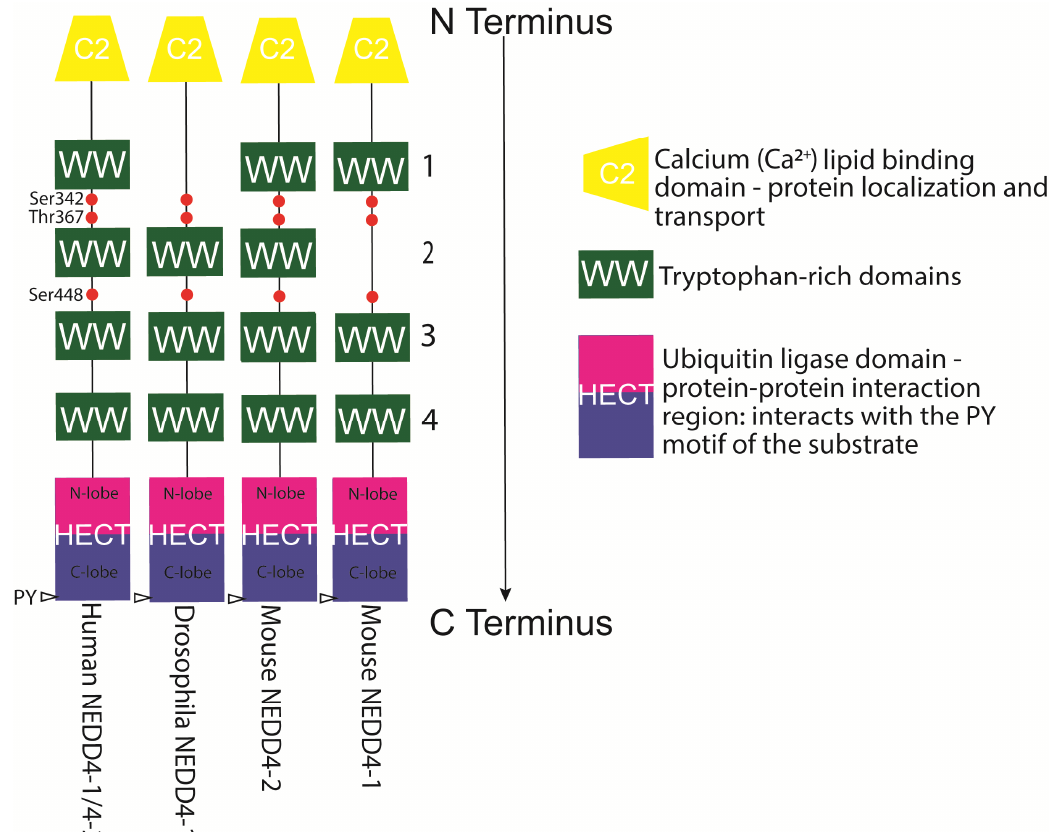
Figure 2. Schematic structural representation of NEDD4-1 and NEDD4-2 proteins in humans, mice, and fruit flies. The NEDD4 family of ligases is defined by its modular structure, a lipid-binding/Ca 2+ (C2) domain at the N-terminus, a number of WW domains in the middle section, and a HECT ubiquitin ligase at the C-terminus, the latter of which is required for its E3 ubiquitin ligase function. NEDD4’s WW domains can interact with PY (proline-tyrosine) motifs to recruit them for ubiquitination. This includes NEDD4’s own PY motifs located on the C terminus. Alternative splicing in mice has led some NEDD4-2 variants to lack a C2 domain, although in neurons, NEDD4-2 predominantly contains a C2 domain. WW domains regulate substrate recruitment for ubiquitination and may be expanded in higher-order organisms [111,215]. Common NEDD4 phosphorylation sites are indicated in red.